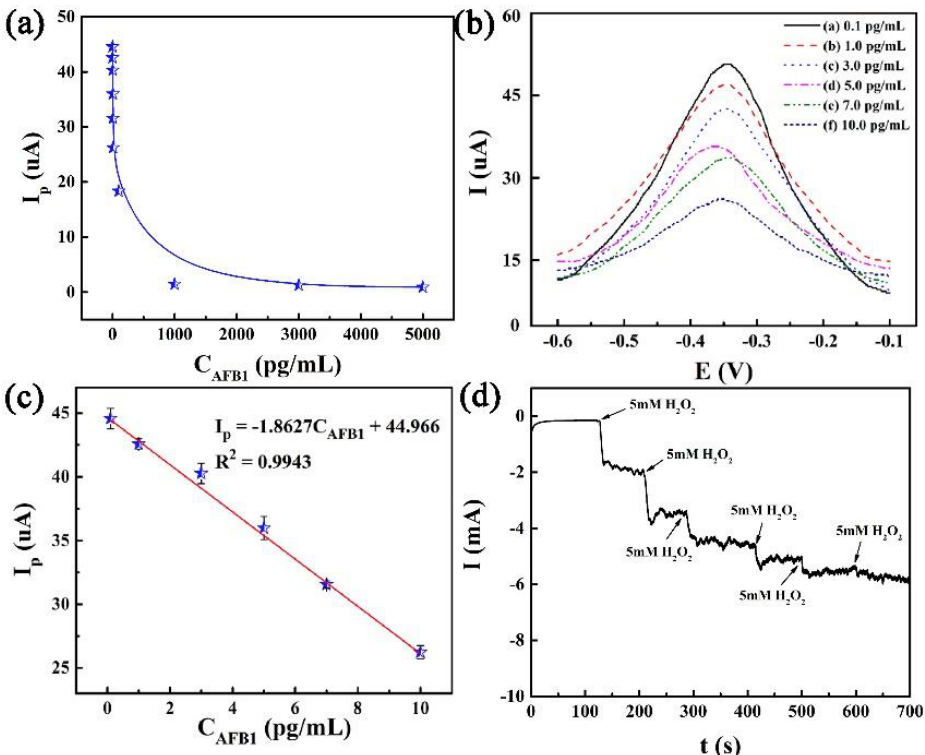
Figure 4. ( a ) I p response of the biosensor to different concentrations of AFB 1 in a large concentration range of 0~5000 pg mL − 1 . DPV responses of the biosensor recorded in 10 mM H 2 O 2 with varying concentrations of AFB 1 ( b ) and corresponding calibration curves of the biosensor for the detection of AFB 1 ( c ). Error bars were obtained from three independent measurements. ( d ) I-t curve of the biosensor recorded in varying H 2 O 2 concentrations.